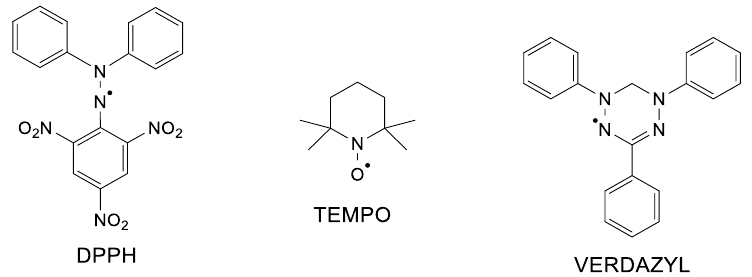
Figure 1. Chemical structure of a hydrazyl, nitroxide, and a verdazyl free radical.